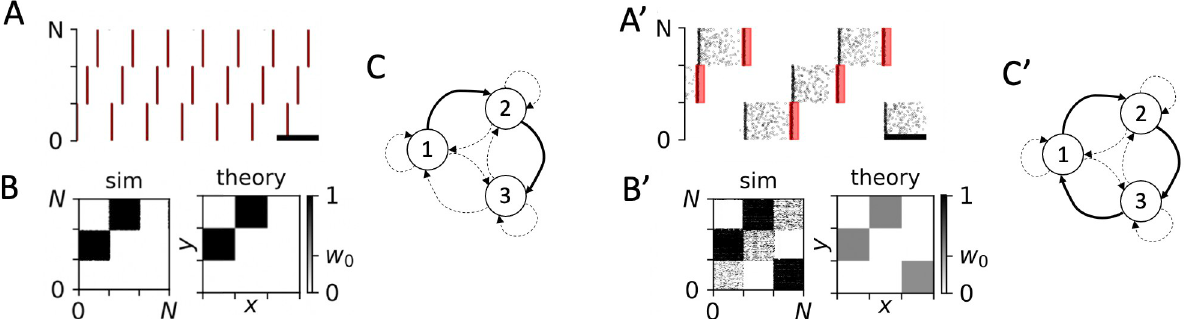
Fig 12. PMCS-induced feed-forward and circular network structure. A: Raster plot of simulated spiking activity in the LIF network model 1000 sec after onset of PMCS with single-pulse stimuli and small positive phase lags between subsequent subpopulations. B: Snapshots of simulated synaptic weight matrix after 1000 sec of stimulation (sim) and the corresponding theoretical prediction obtained from Eq 1 (theory). C: Schematic of stimulation-induced feed-forward structure (see caption of Fig 9 for symbols). A’-C’: Same as A-C but for slow PMCS with long single-pulse stimuli. The phase lags were adjusted to cause a circular network structure. Parameters: A stim = 0.4 and Δ α 1/2 = 0.3 (A-C), and Δ α 1/2 = 0.33 (A’-C’) and d e = 1 and f = 10 Hz (A-C), and d e = 20 and f = 2.5 Hz (A’-C’).